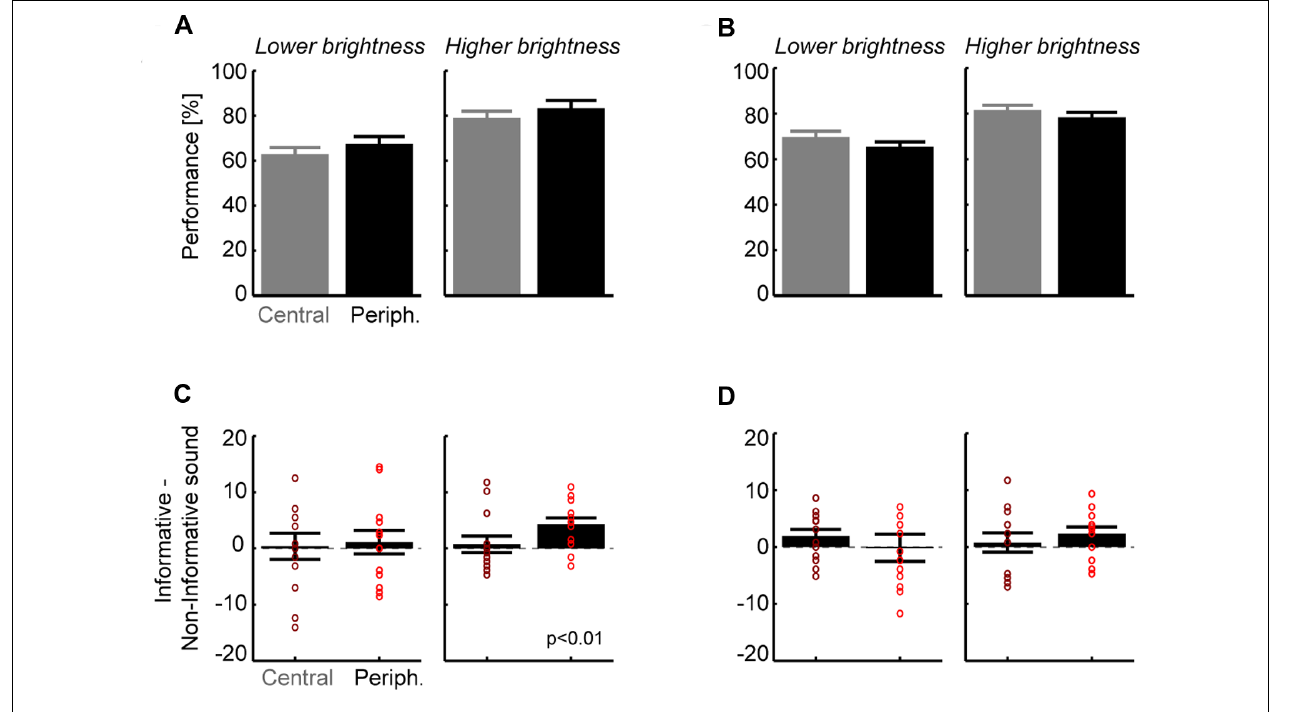
peripheral locations was significant ( t = 3.7, df = 12; p < 0.01; p < 0.05 after Bonferroni correction). (C) Group level performance for the discrimination task. Again performance did not differ between locations but was higher for brighter targets as expected. (D) Contrast between informative and non-informative sounds for stimulus discrimination. No difference reached statistical significance but there was a trend for the brighter target and peripheral locations ( t = 2.0, df = 12, p = 0.06